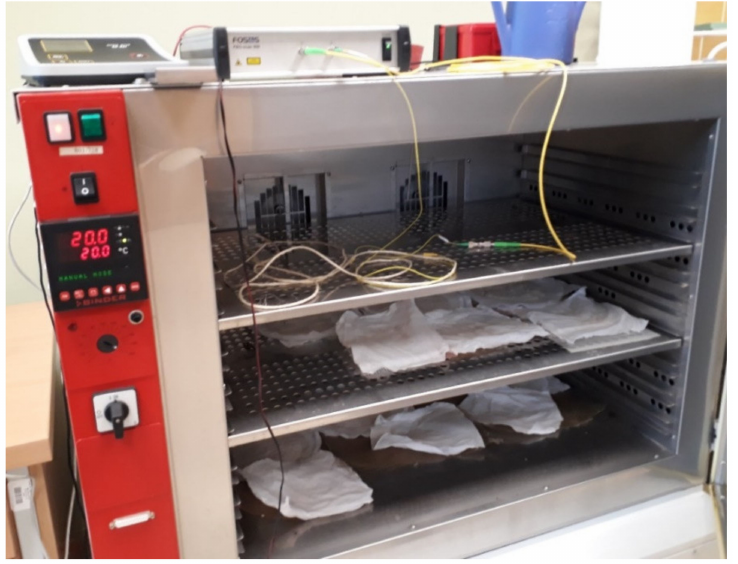
Figure 4. Climatic